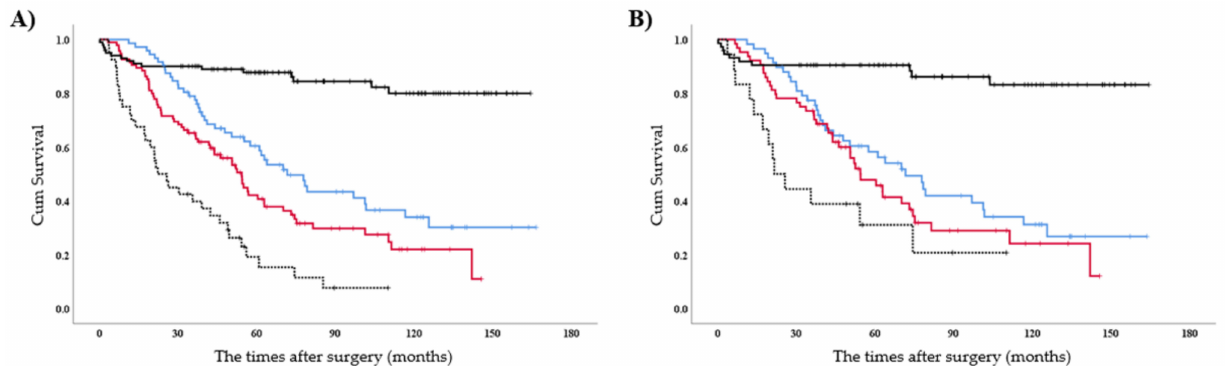
Figure 3. Kaplan–Meier curves in subgroup analyses. Overall survival curve after surgical tumour resection ( A ) before and ( B ) after propensity adjustment. Black, blue, red, and dotted lines represent no recurrence (NR group), both adjuvant treatments after surgical resection and guideline-matched first-line treatment for recurrence (guideline-consistent group), either treatment (EAG group), and neither treatment (guideline-inconsistent